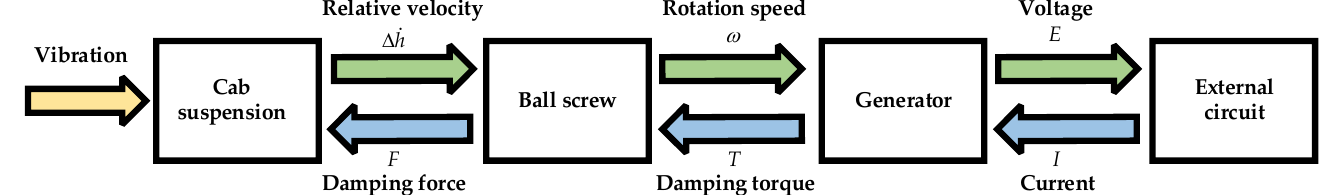
Figure 5. The energy flow of electromagnetic damper.